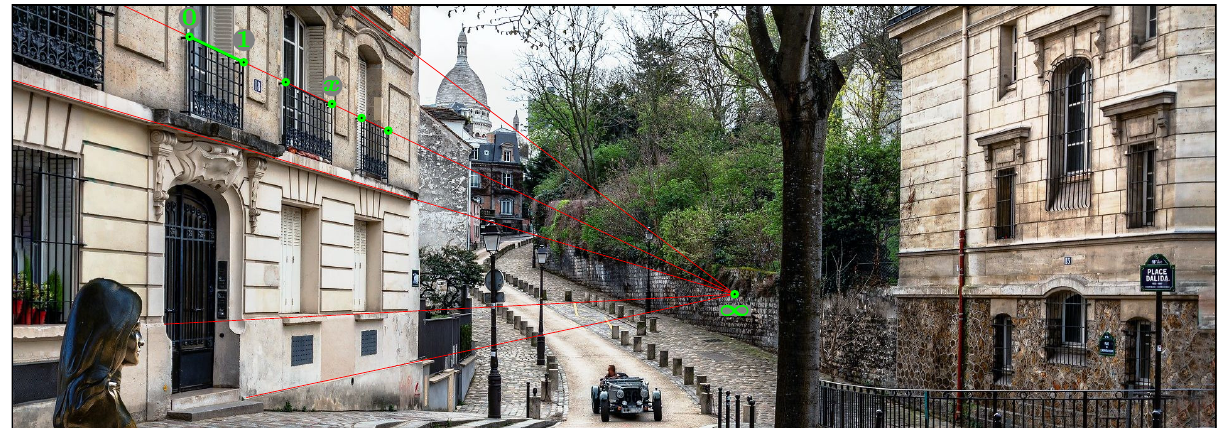
Figure 4. Place Dalida, Paris (Photo by endmondlafoto, 2018). Red lines show parallel lines found on the facade of the left building meeting in their vanishing point ( ∞ ). The other greed dots are placed on a line and mark the edges of the ralings on the second floor of the building. The length of the first railing is defined as unit length. The rectified position of an arbitrary other point x on that line can be found by the cross-ratio ( ∞ , 0 ; 1 , x )